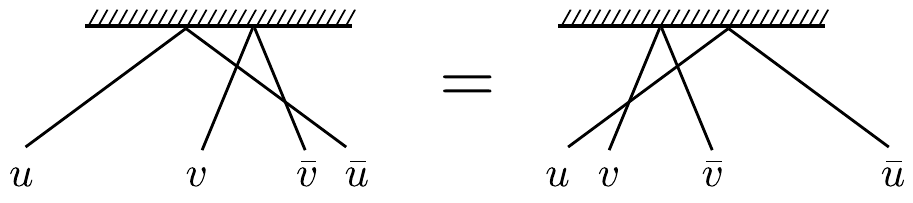
Figure 26 . The boundary Yang-Baxter equation in the form factor